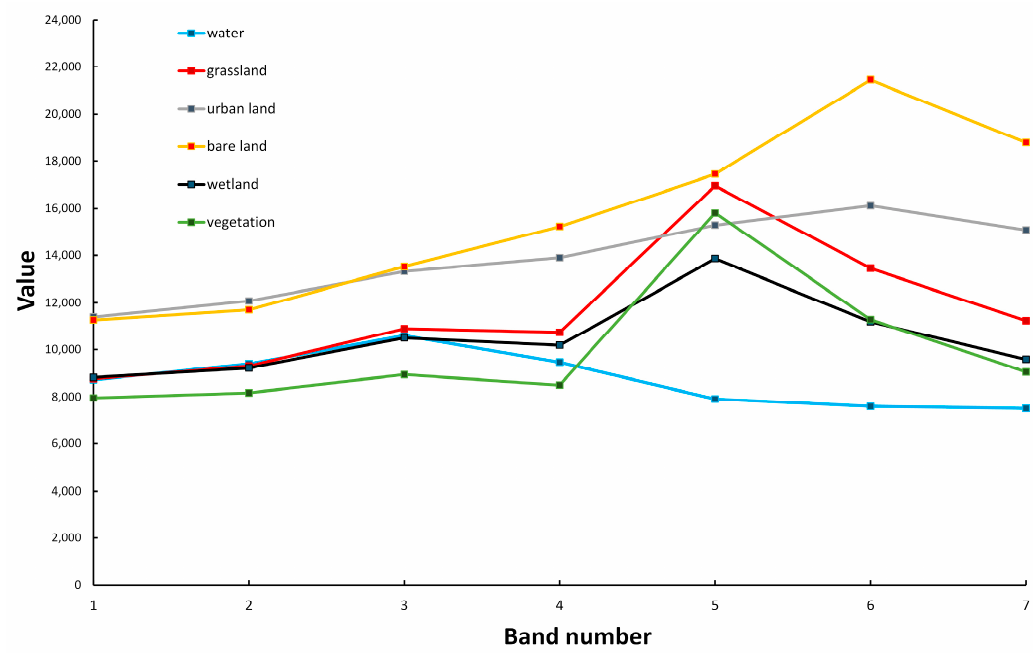
Figure 2. Spectral characteristics of the Landsat TM image for different land types.